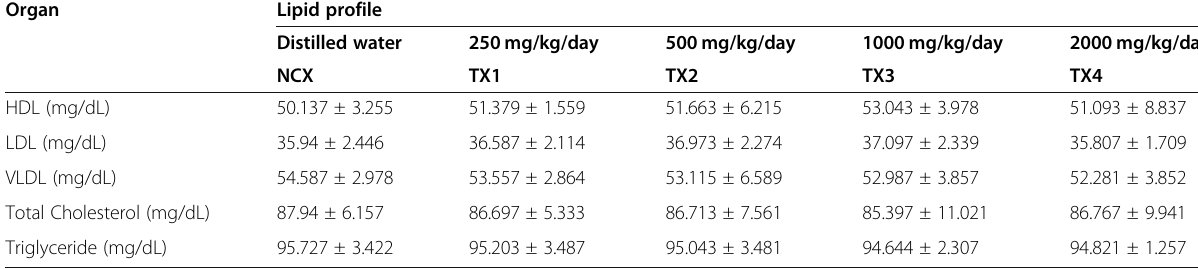
Table 9 Effect of polyherbal combination (PHC) on lipid profile